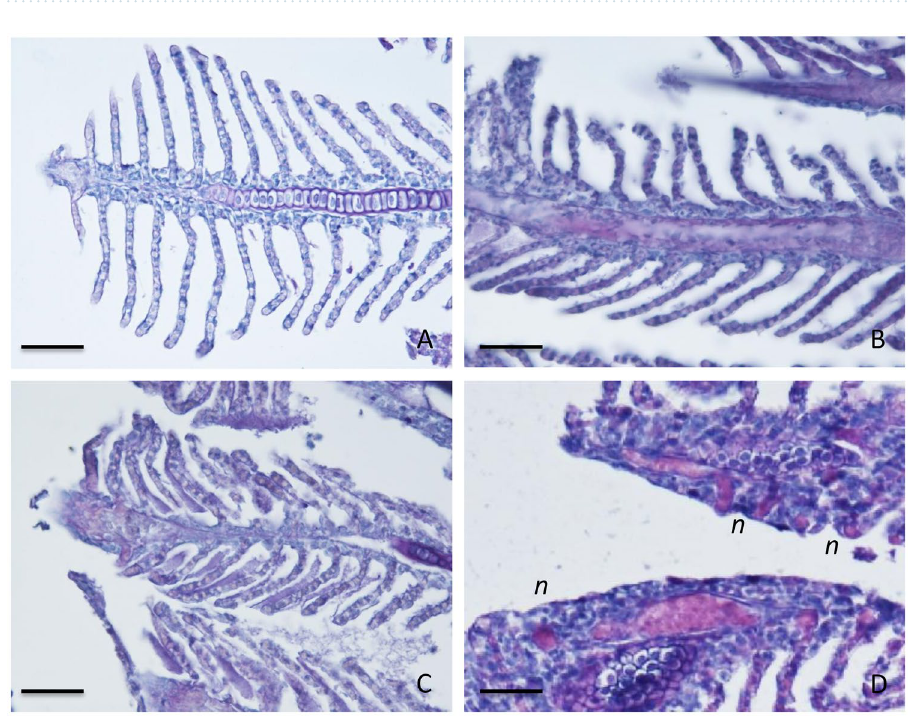
Figure 5. Histology of gills. Representative sections of gill lamellae stained with PAS with HH nuclear counterstain. CNTR (Control) in ( A ); L-MPs (100 µ g/L) in ( B ); H-MPs (1000 µ g/L) in ( C ). Note in ( D ) (L-MPs) high occurrence of neutrophils (n). Scale bar: 50 µ